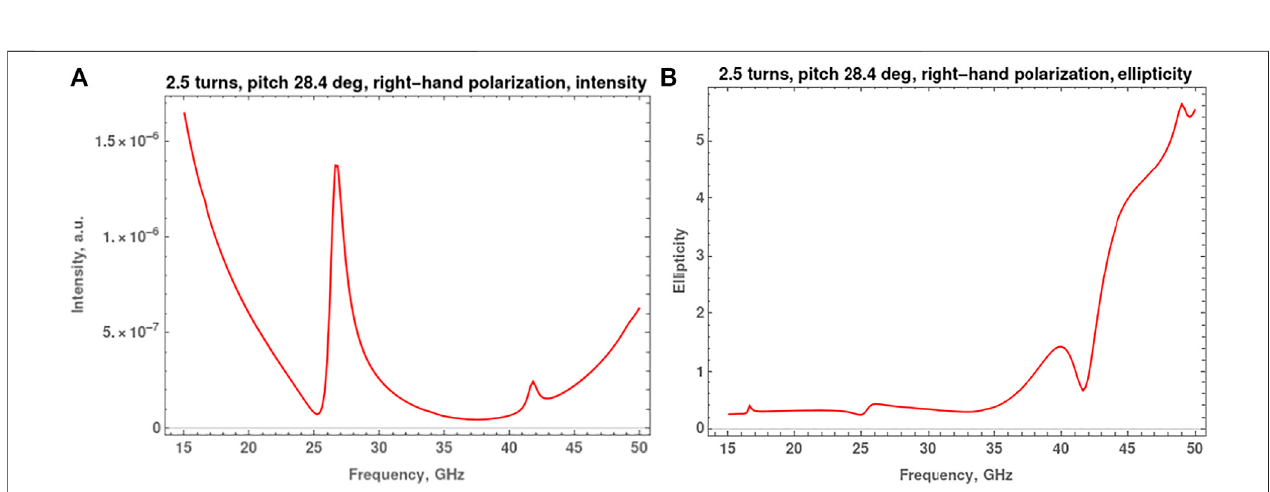
FIGURE 5 | (A) Dependence ofthe intensity of the re fl ected wave by double-stranded DNA-like helix on the frequency for an incident wave with right-hand circular polarization (the case of weak excitation of currents). (B) Dependence of the ellipticity of the re fl ected wave under the same conditions.